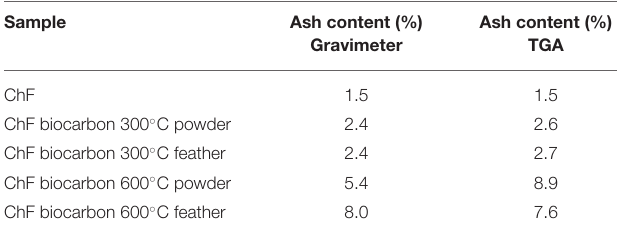
TABLE 2 | Ash content of ChF and ChF biocarbon determined via gravimetric and TGA analyzes.